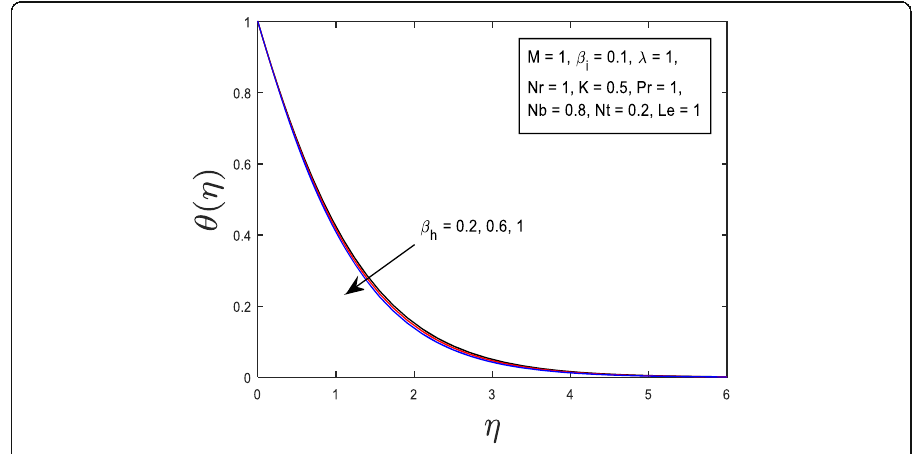
Fig. 8 Graph of temperature for various values of β